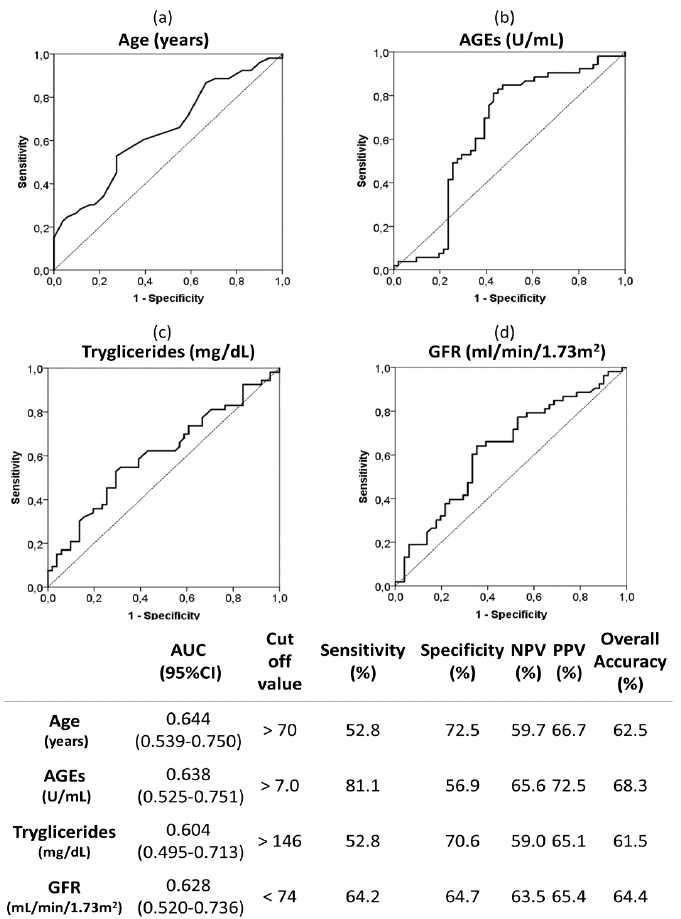
Figure 3. Receiver operating characteristic (ROC) curves and optimal cut-off of the following 231 Figure3. Receiveroperatingcharacteristic(ROC)curvesandoptimalcut-o ff ofthefollowingquantitative quantitative risk factors associated to moderate-severe AAC (vs. no-mild AAC): age (a), AGEs (b), 232 risk factors associated to moderate-severe AAC (vs. no-mild AAC): age ( a ), AGEs ( b ), triglycerides ( c ) triglycerides (c) and GFR (d). The optimal cutoff values were determined by the maximum Youden 233 and GFR ( d ). The optimal cuto ff values were determined by the maximum Youden index (J), defined as index (J), defined as sensitivity + specificity −1. The table indicate the area under the curve (AUC), 234 sensitivity, specificity, positive predictive value (PPV), negative predictive value (NPV) and overall 235 sensitivity + specificity − 1. The table indicate the area under the curve (AUC), sensitivity, specificity, accuracy of the optimal cut off values. Abbreviations. AGEs; advanced glycation end products; GFR: 236 positive predictive value (PPV), negative predictive value (NPV) and overall accuracy of the optimal glomerular filtration rate. 237 cut o ff values. Abbreviations. AGEs; advanced glycation end products; GFR: glomerular filtration